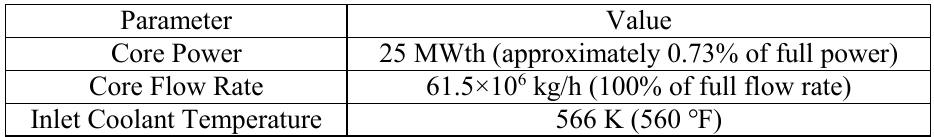
Table I. Core Condition of HZP Physics Test.